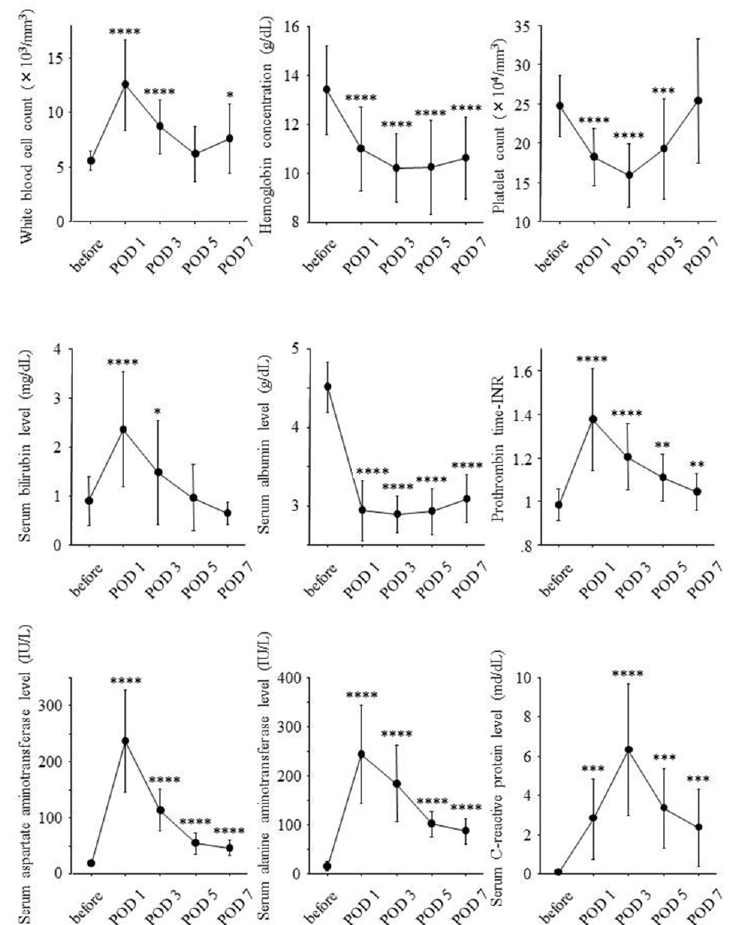
Liver resection rate was significantly correlated with white blood cell counts on POD 1 ( r = 0.65, p = 0.005), serum bilirubin levels on POD 3 ( r = 0.51, p = 0.045), serum albumin levels on POD 3 ( r = 0.57, p = 0.020), serum aspartate aminotransferase levels on POD 3 ( r = 0.63, p = 0.007) and POD 5 ( r = 0.81, p = 0.0006), and prothrombin time-international normalized ratio (INR) on POD 3 ( r = 0.71, p = 0.002) and POD 5 ( r = 0.78, p = 0.004) but was inversely correlated with serum C -reactive protein levels ( r = − 0.67, p = 0.005). Remnant liver volume per body weight on POD 0 was inversely correlated with white blood cell counts on POD 1 ( r = − 0.61, p = 0.011), serum aspartate aminotransferase levels on POD 3 ( r = − 0.78, p = 0.0002) and POD 5 ( r = − 0.78, p = 0.019), and prothrombin time-INR on POD 3 ( r = − 0.68, p = 0.003) and POD 5 ( r = − 0.78, p = 0.003) but was significantly correlated with serum C-reactive protein levels ( r = 0.66, p = 0.006). According to remnant liver volume per body weight on POD 0, 16 patients were divided into two groups. One group consisted of eight patients with remnant liver volume per body weight on POD 0 of 10 cm 3 /kg or less, and another group consisted of the other eight patients with remnant liver volume per body weight on POD 0 >10 cm 3 /kg. Serial changes of laboratory data in both the